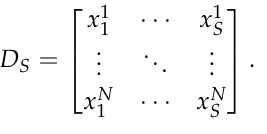
= 1800 acquired in our test j